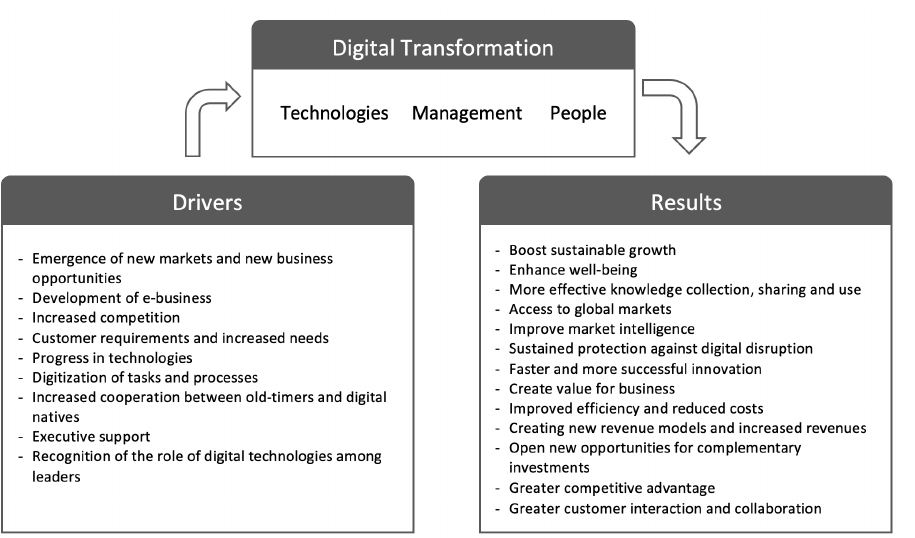
Figure 1. Conceptual model of digital transformation (adapted from